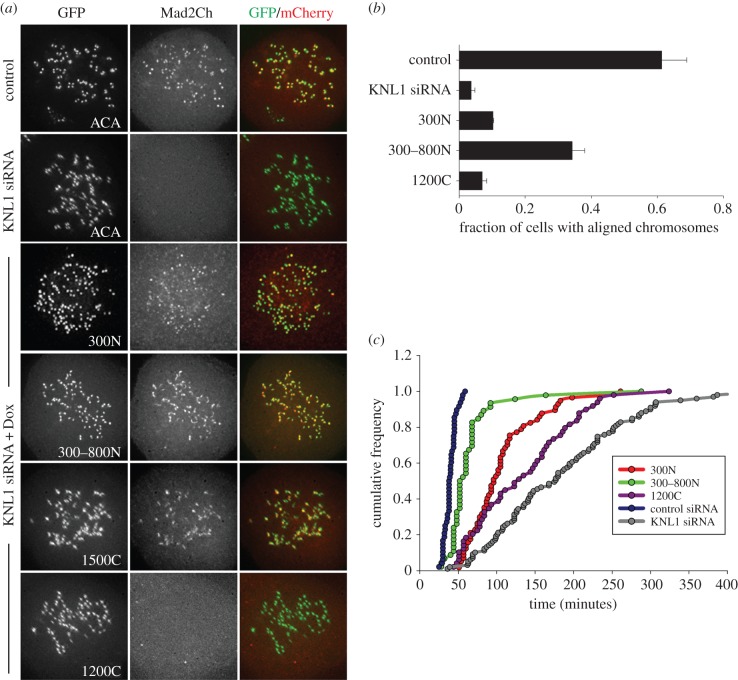
KNL1 N-terminus is required for Mad2 kinetochore localization. (a–c) Flp-In T-REx HeLa cells were depleted of endogenous KNL1, rescued with the indicated GFP-KNL1 fragment upon doxycycline addition, and (a) overexpressed for Mad2-mCherry, (b) analysed for chromosome alignment or (c) analysed by live-cell imaging to determine time from nuclear envelope breakdown to anaphase. (b) Error bars represent s.d. between experiments, n = 3 independent experiments and n ≥ 50 cells scored per experiment. (c) Cumulative frequency of timing through mitosis.